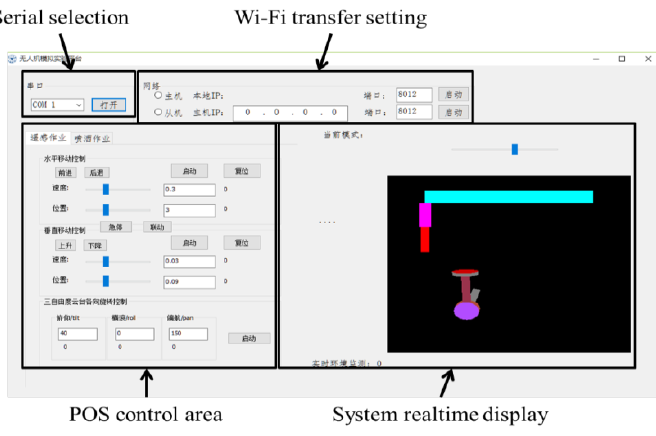
Figure 7. Upper machine software GUI.